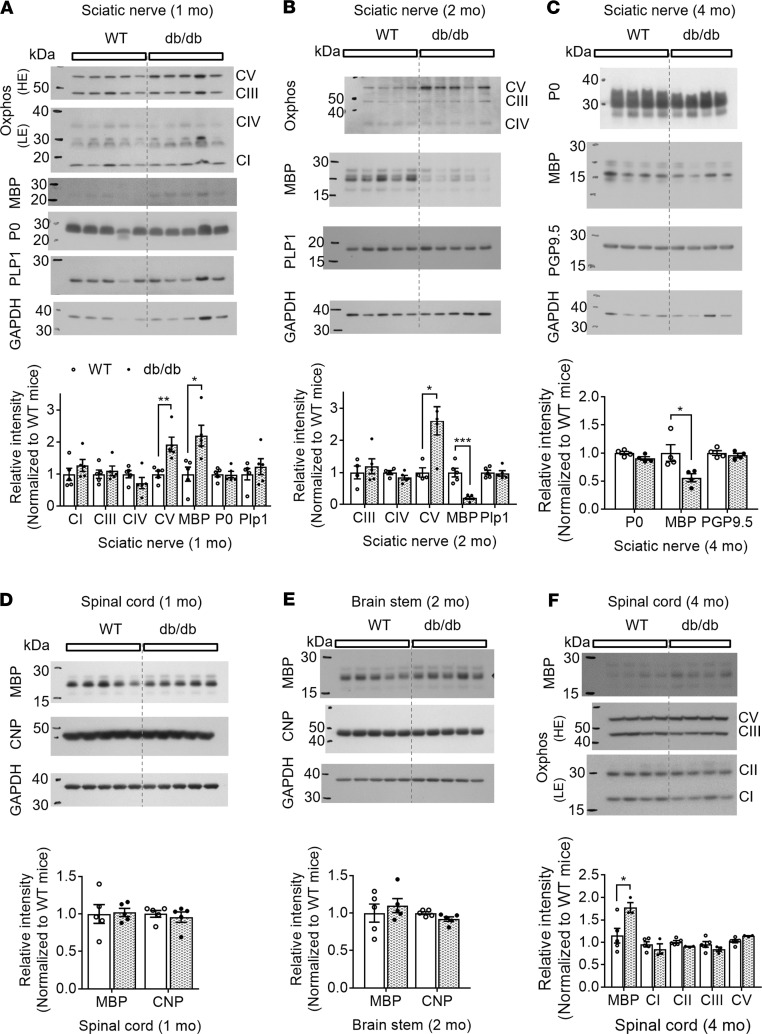
Alterations in specific mitochondrial and myelin-specific proteins in obese diabetic mice.Sciatic nerve, spinal cord, and/or brainstem NP-40 homogenates (supernatants) from 1-month-old (A and D), 2-month-old (B and E), and 4-month-old (C and F) WT and db/db mice. Representative Western blots using oxidative phosphorylation (OXPHOS) rodent antibody cocktail, as well as antibodies against proteolipid protein 1 (PLP1), myelin basic protein (MBP), P0 (myelin protein zero, MPZ), and cyclic-nucleotide phosphodiesterase (CNP). Relative intensities (normalized to WT mice) were quantified using ImageJ software. GAPDH is shown as an example of a loading control. Relative intensities for each protein were compared between genotypes using unpaired 2-tailed Student’s t tests. Graphs are presented as dot plots with bars; each dot represents a different animal; data represent the mean ± SEM of n = 4–5 mice/genotype for all panels. *P < 0.05, **P < 0.01. Full, unedited versions of the gels are provided in the supplemental material.